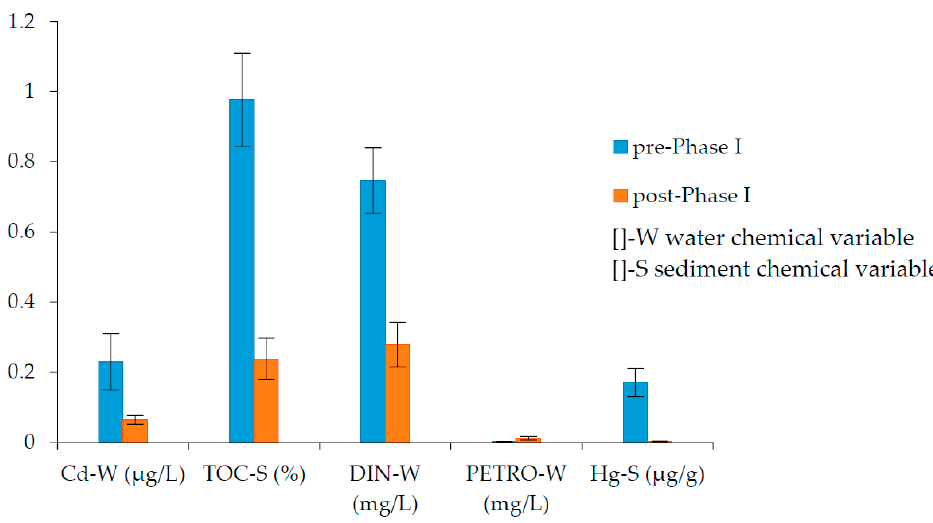
Figure 8. Comparison of measurements of the KEIs between pre- and post Phase I project. Table 5. Multiple regressions of the KEIs on the phytoplankton